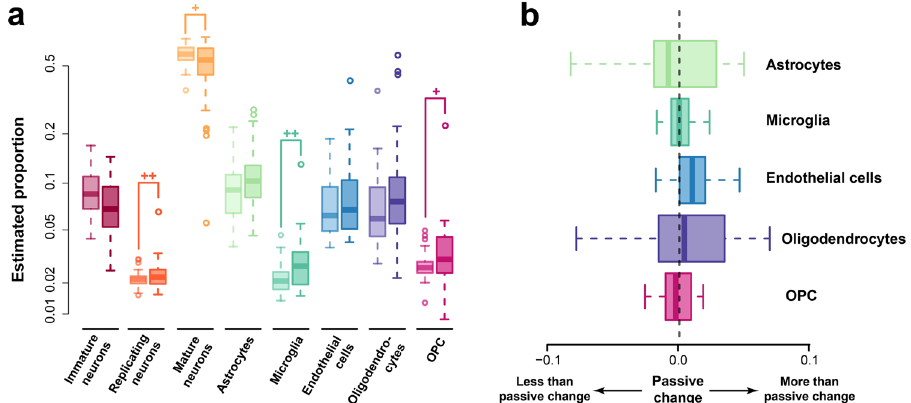
Figure 5. Alteration of cell type composition in autism. (a) The estimated proportions of each cell types in autism case samples and healthy control samples with ages at the same age range. Each pair of boxes with the same color show the proportions of one cell type, with the left box represents the proportions in healthy samples, and the right box represents the proportions in autism samples. The plus signs mark significant difference according to Wilcoxon’s test ( +− P < 0.1; ++− P < 0.05). ( b ) The disparity of observed altered non- neuron cell type compositions and the predicted altered compositions with the assumption of passive change of non-neuron cell type composition. Each box with a different color showed the observed altered proportion of one non-neuron cell type subtracted by the predicted altered proportion of the cell type based on the altered proportion of neurons scaled by the relative proportions of the non-neuron cell type in healthy